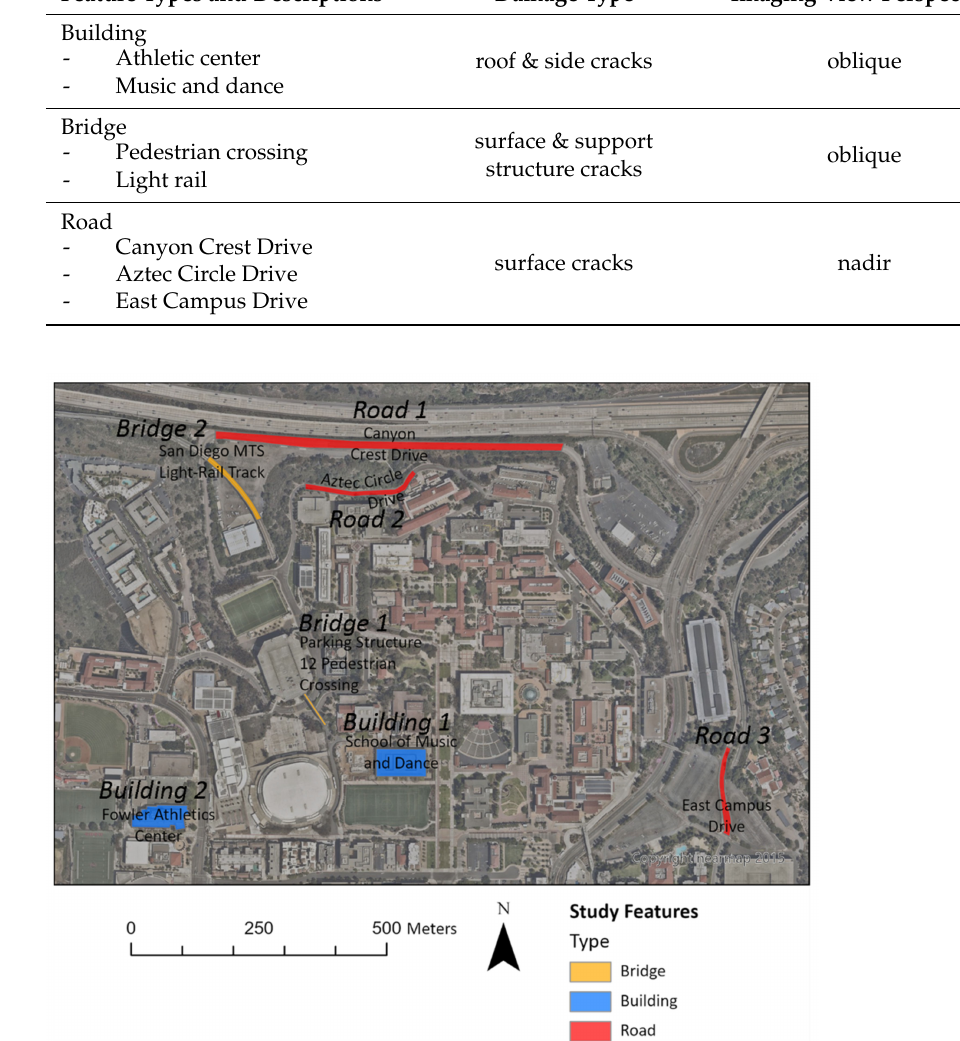
Figure 2. Image map showing the study sites within the San Diego State University campus study